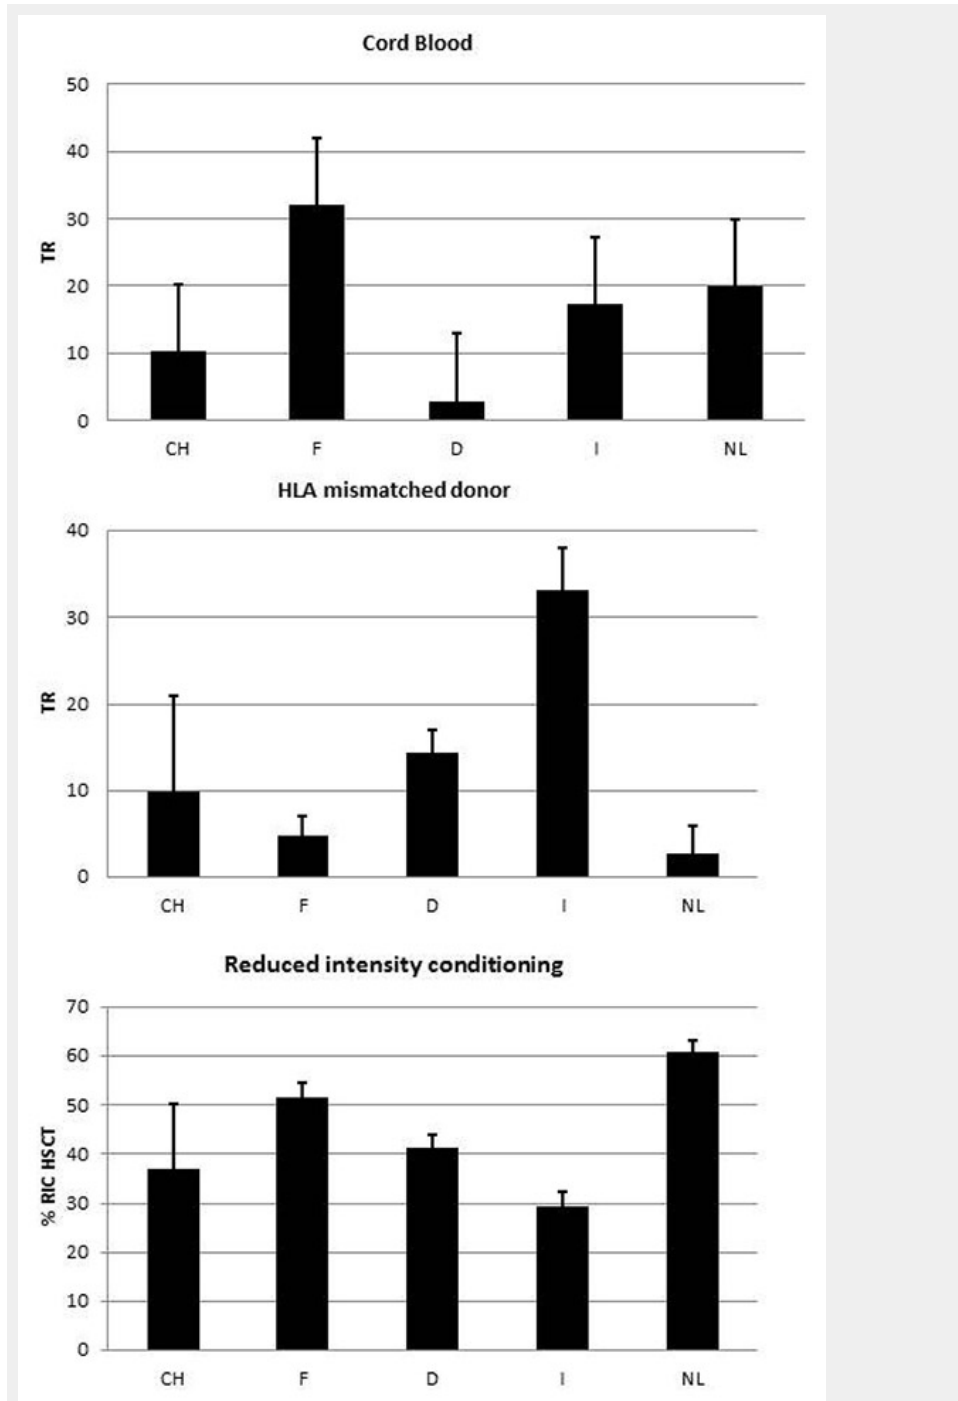
Figure 4 Allogeneic HSCT rates per 10 million inhabitants and year. 4a: use of cord blood transplants. 4b: use of HLA- mismatched family donors. 4c: use of reduced intensity conditioning as percentage of all allogeneic HSCT (CH: Switzerland, F: France, D: Germany, I: Italy, NL: the